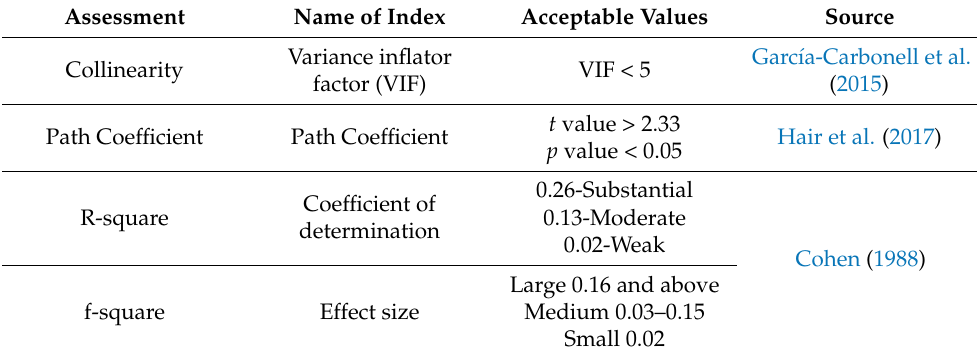
Table 3. Acceptable Values for Model Evaluation—Structural Model Analysis.